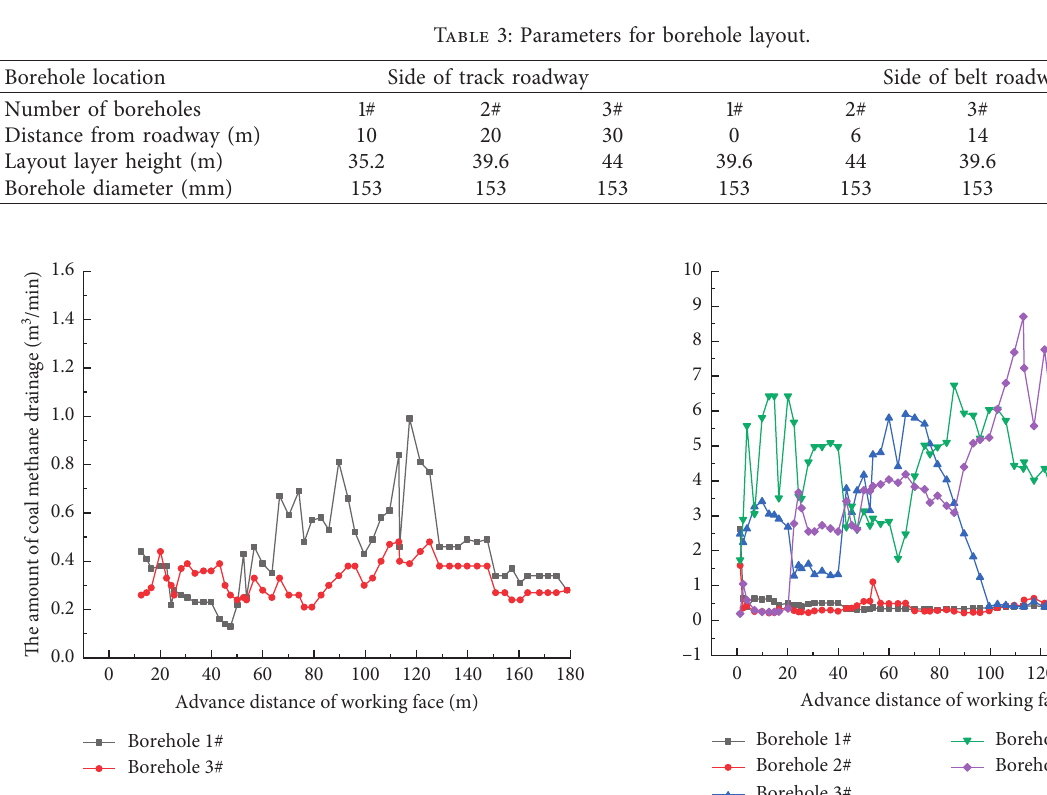
Figure 18: Data of CBM drainage from directional boreholes in the fracture zone on the side of the track roadway. Figure 19: Data of CBM drainage from directional borehole in the fracture zone on the side of belt